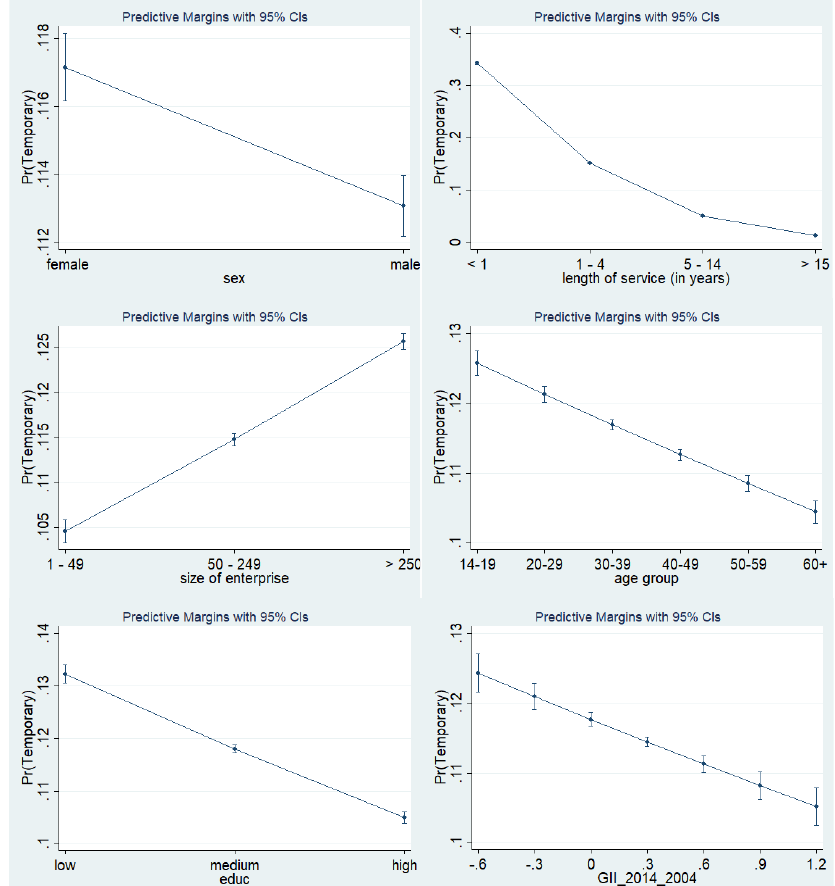
Figure 3. Margins plots corresponding to estimation results from column (1)